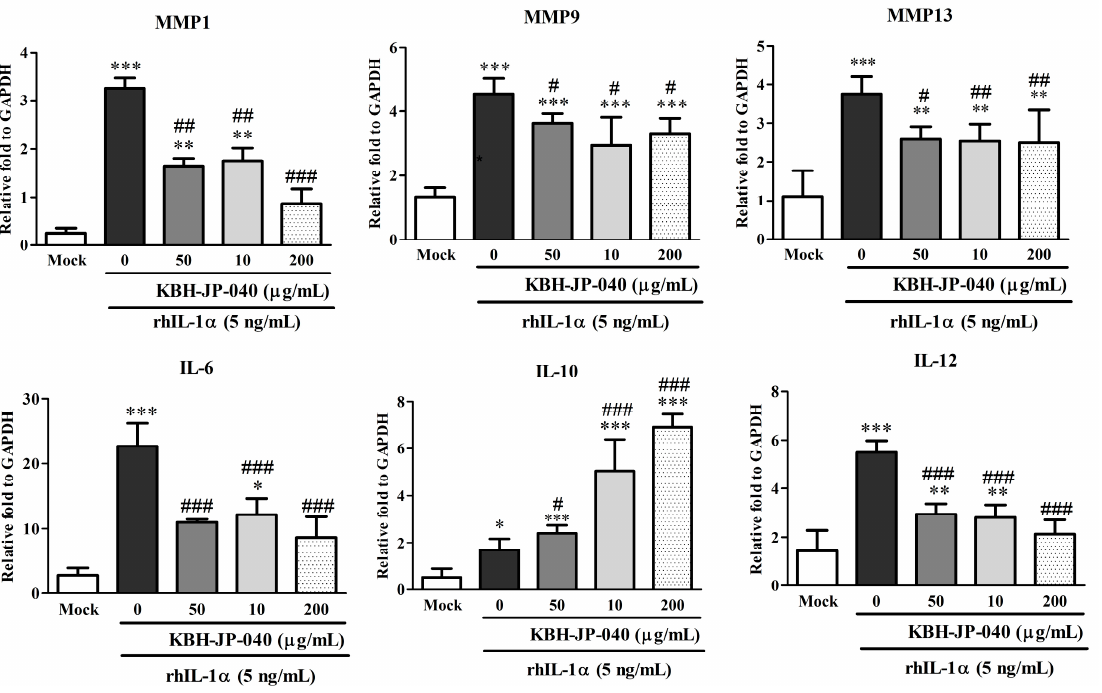
Figure 2. Effect of treatment of KBH-JP-040 on MMP and IL protein expression in rat chondrocytes measured by RT-PCR. Mock, normal chondrocytes; RhIL-1, 5 ng/mL recombinant human IL-1-treated group; RhIL-1+SE50, rhIL-1 and standardized extract , KBH-JP-040 50 μ g/mL-treated group; RhIL-1+ KBH-JP-04050, rhIL-1- and KBH-JP-040 50 μ g/mL-treated group; RhIL-1+ KBH-JP-040100, rhIL-1- and KBH-JP-040 100 μ g/mL-treated group; RhIL-1+ KBH-JP-04050, rhIL-1 and KBH-JP-040 150 μ g/mL-treated group. The data are reported as means ± SD. *: p < 0.05; **: p < 0.01; and ***: p < 0.001, Bonferroni post hoc test following one-way ANOVA versus the mock group; #: p < 0.05; ##: p < 0.01; and ###: p < 0.001, Bonferroni post hoc test following one-way ANOVA versus RhIL-1 group. All experiments were performed using three replicates.